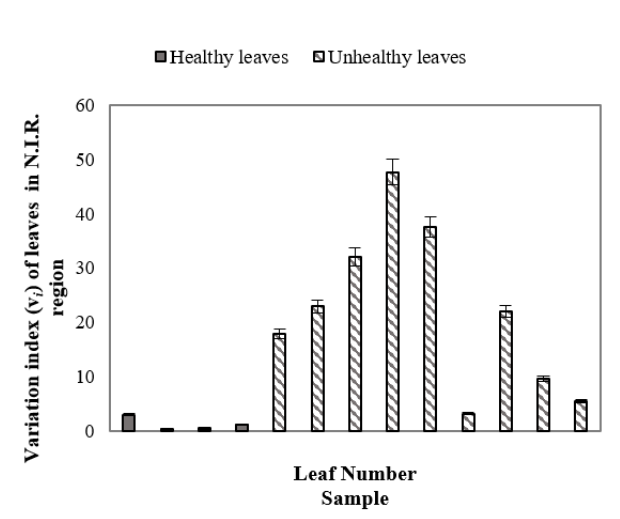
Figure 7. Variation index ( v i ) of healthy and unhealthy leaves in the N.I.R. region, indicating the difference between healthy and unhealthy leaves.